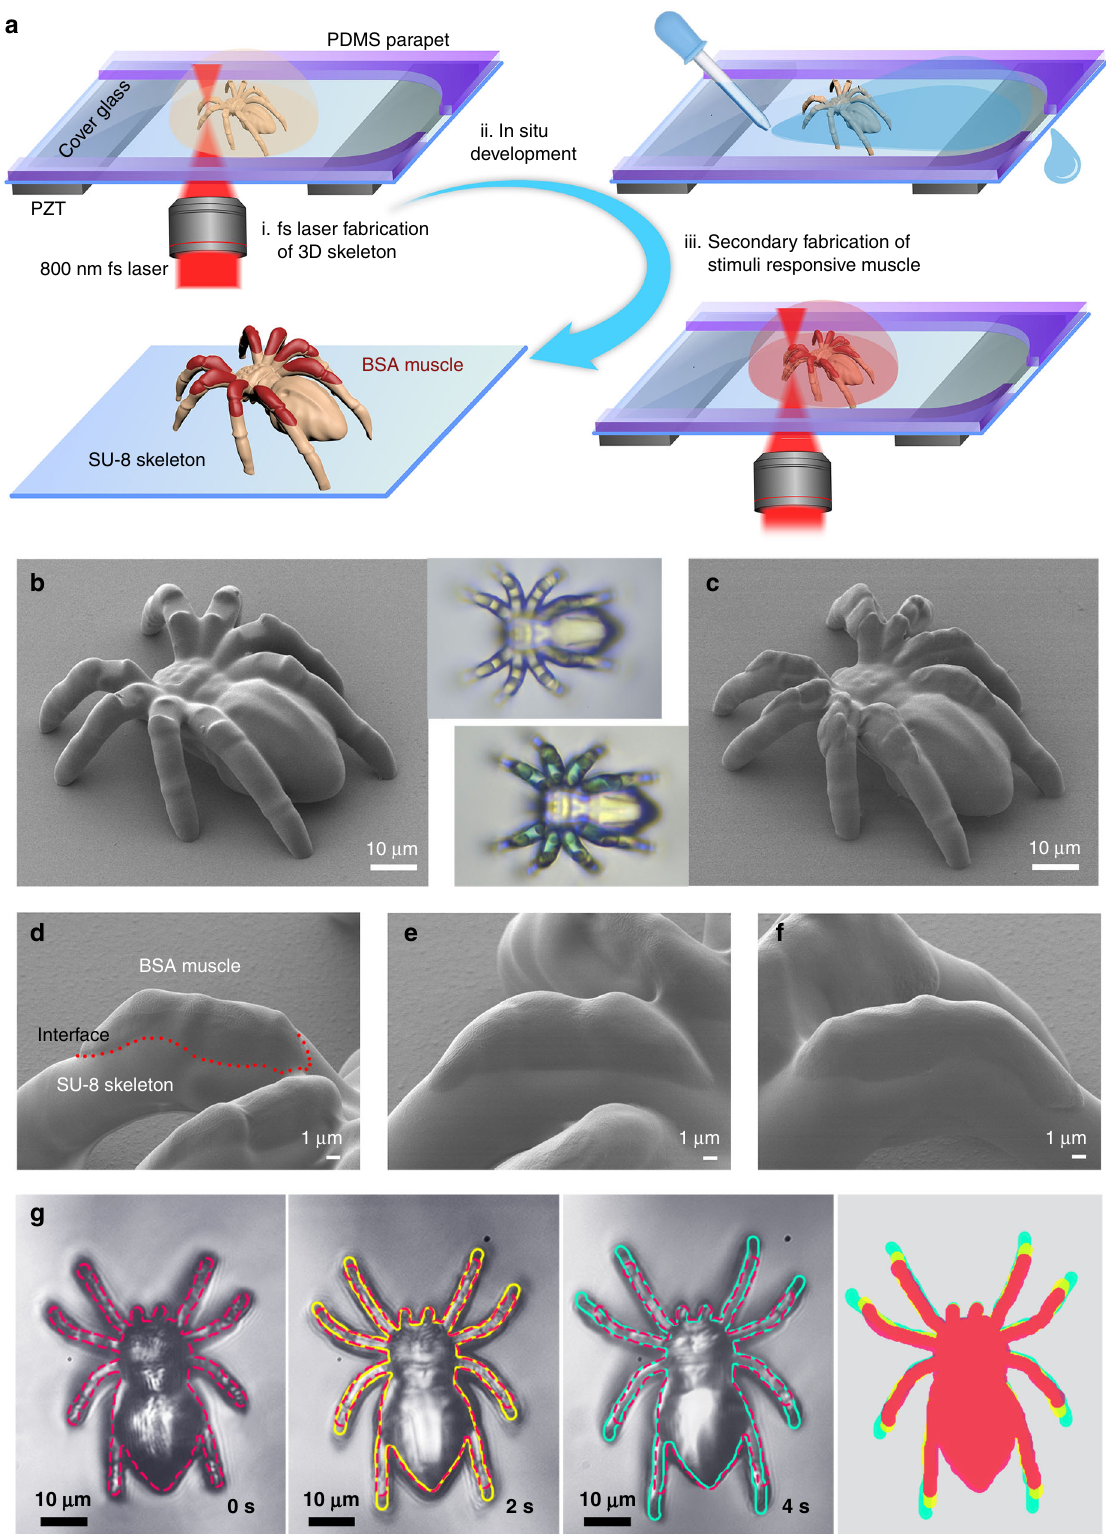
of C – C. For BSA, the typical peaks at 3303, 1651, and 1536 cm − 1 correspond to the Amide A band (mainly N – H stretching vibration), Amide I band (stretching vibration of C = O),